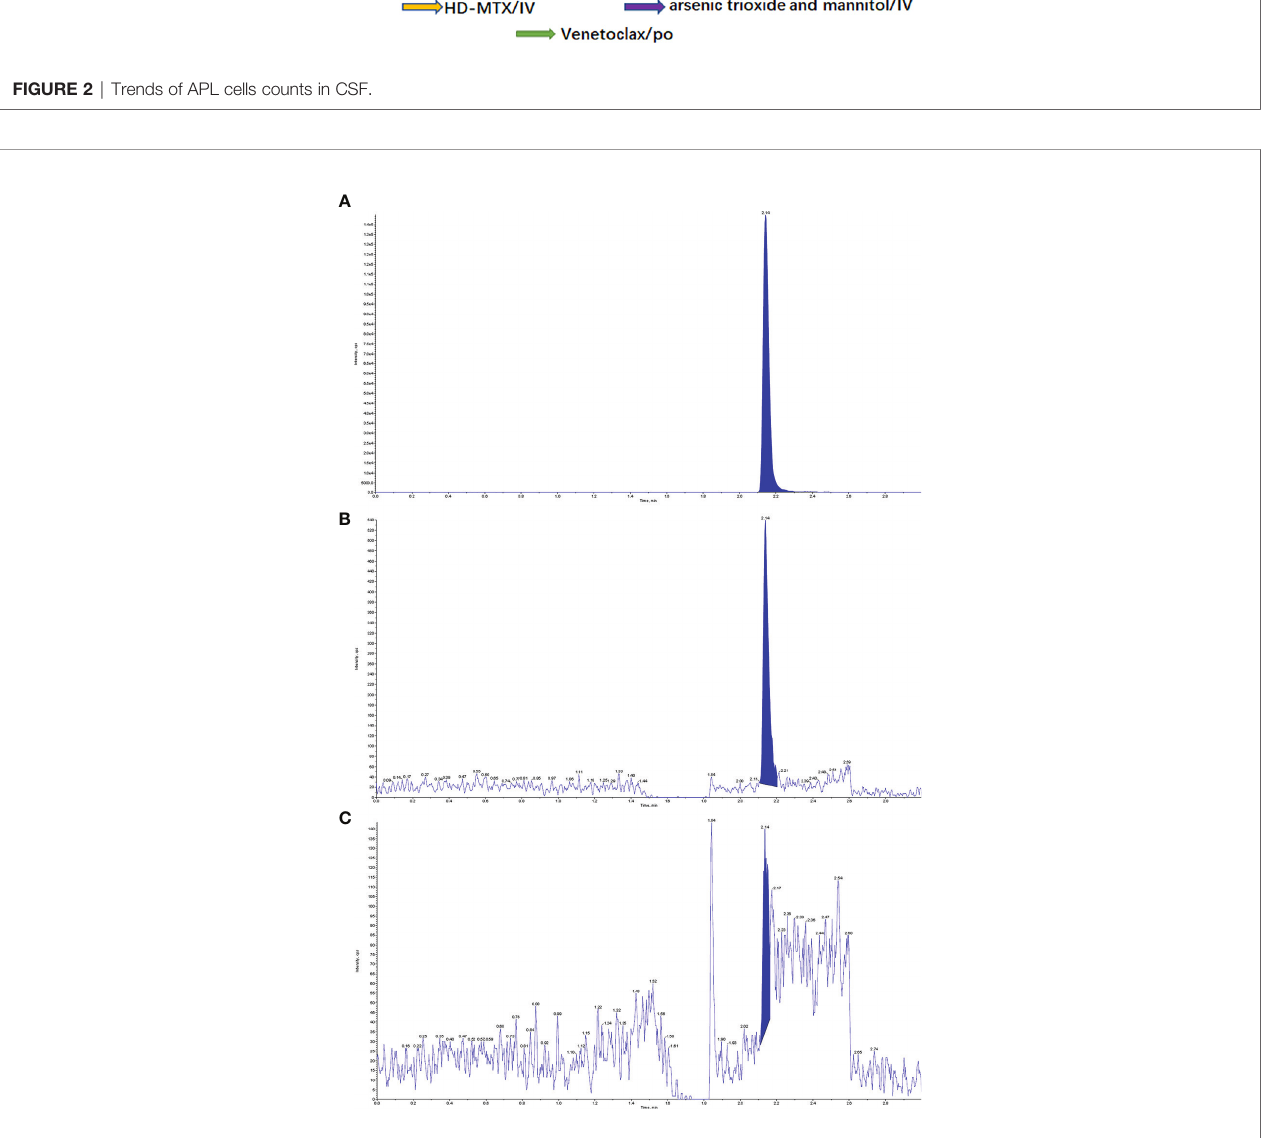
FIGURE 3 | Detection of venetoclax in plasma and CSF by mass spectrometry. (A) Plasma venetoclax valley concentration; (B) Venetoclax concentration in the patient ’ s CSF; (C) Background concentration of venetoclax in the patient ’ s CSF before starting